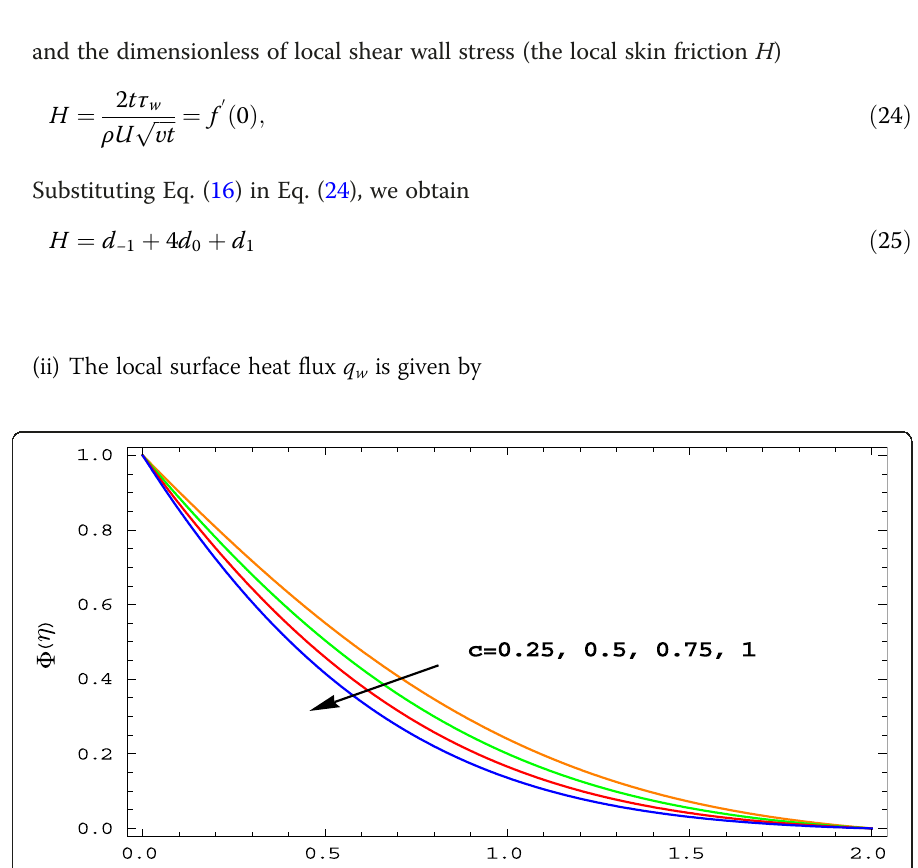
Fig. 13 Fluid concentration with increasing of the suction parameter ( c